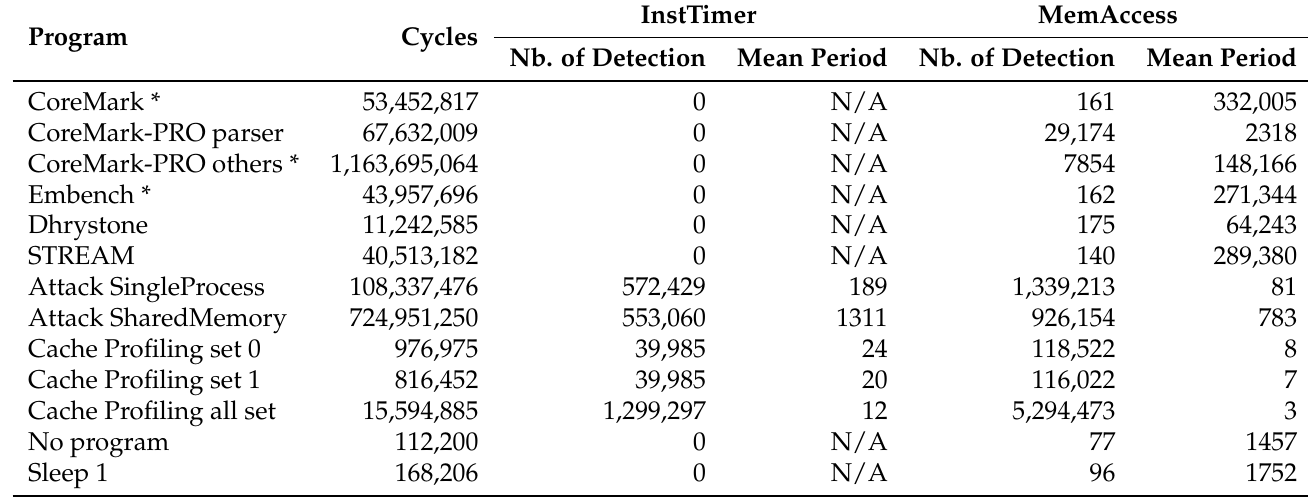
Table 2. Evaluation of the Prime detection using the instruction-flow-based ( InstTimer ) and memory- access-based ( MemAccess ) pattern counters. For each program, the column nb. of detection is the counter value at the end of the execution, and mean period is the mean cycles between two counter’s increment. Cycles are expressed as DM cycles . Sets of benchmarks are noted with * and only the mean value is